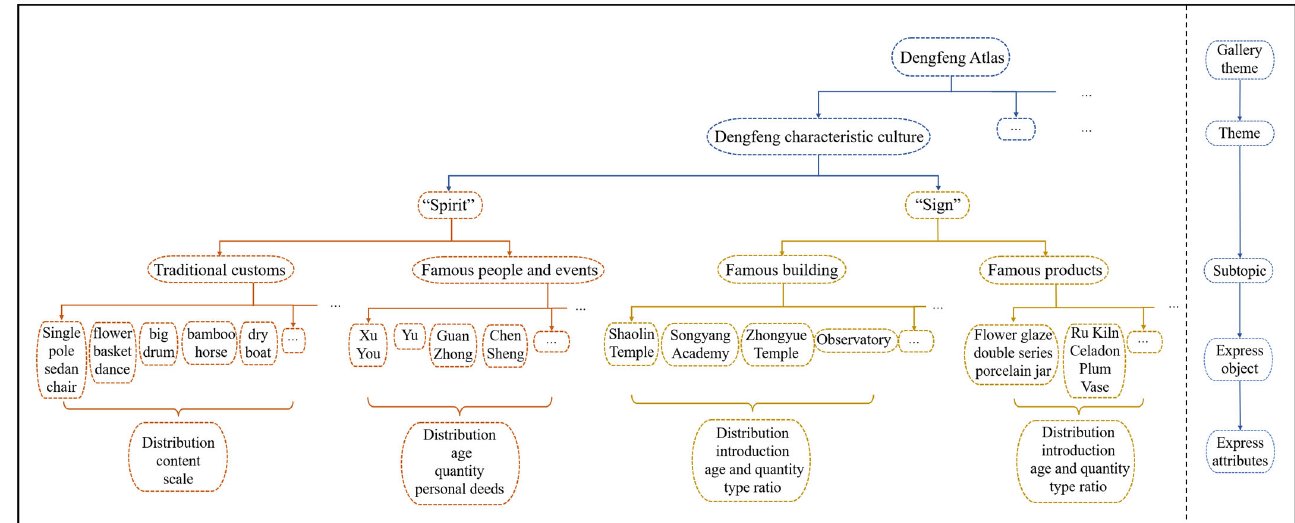
Figure 5. “Spirit–Sign” content framework of the Dengfeng City Chronicle.